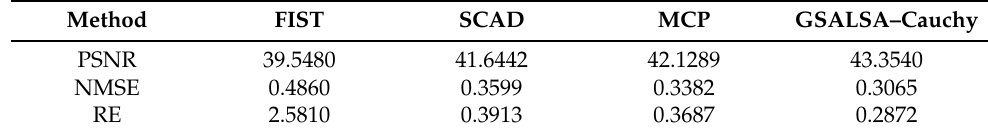
Figure 5. The experimental scenario. ( a ) The corner reflector. ( b ) The pistol. Table 3. PSNR, NMSE and RE of the corner reflector with full sampling.